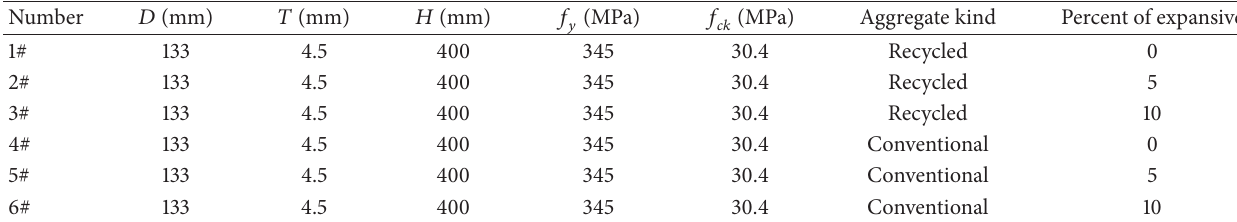
Table 6: Geometrical and mechanical properties of tests columns.